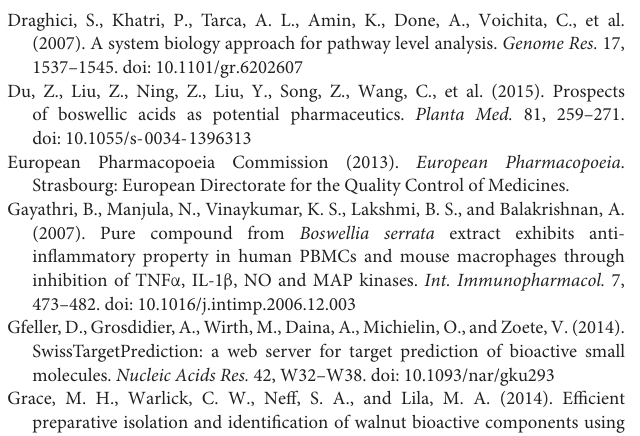
FIGURE S1 | The barplot of canonical pathways associated with the targets. FIGURE S2 | The TIC chromatography of frankincense and processed frankincense. FIGURE S3 | MRM figure for seven compounds in the inner solution of frankincense and processed frankincense. TABLE S1 | Partition coefficient ( K ) values of compounds in different solvent systems. TABLE S2 | The information of the related targets of frankincense. TABLE S3 | The information for MRM